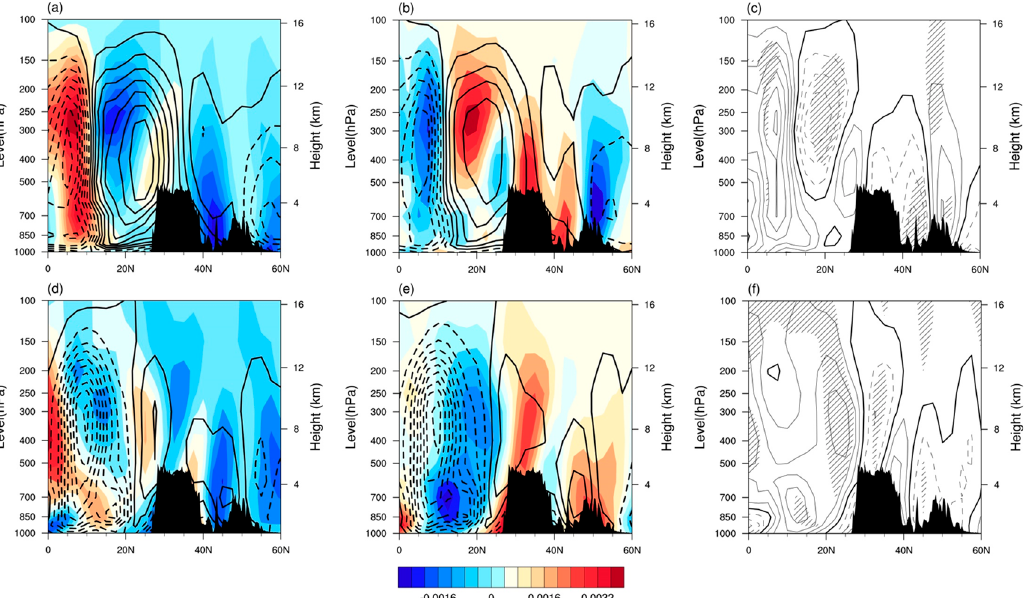
Figure 8. The latitude–height cross-sections of composite anomalies in zonal winds (m/s), averaged over 80°–100° E, in high (left column) and low (middle column) spring snowmelt years and the differences between high and low spring snowmelt (right column): ( a – c ) spring; ( d – f ) summer. The gray shading represents grid point values that were significant at the 90%